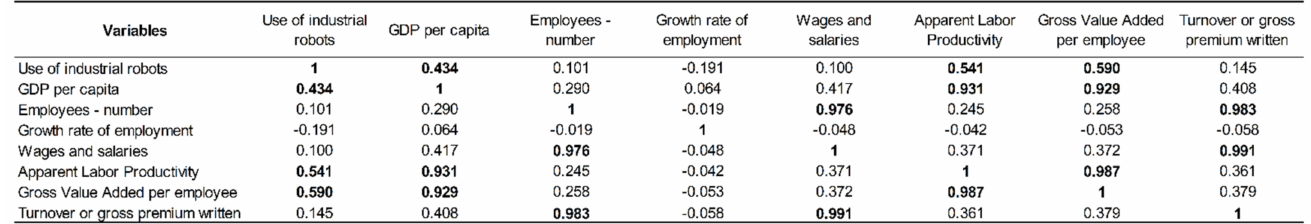
Figure 11. Correlation matrix. Source: Author’s contribution based on data retrieved from Eurostat. Annual enterprise statistics for special aggregates of activities. https://appsso.eurostat.ec.europa.eu/